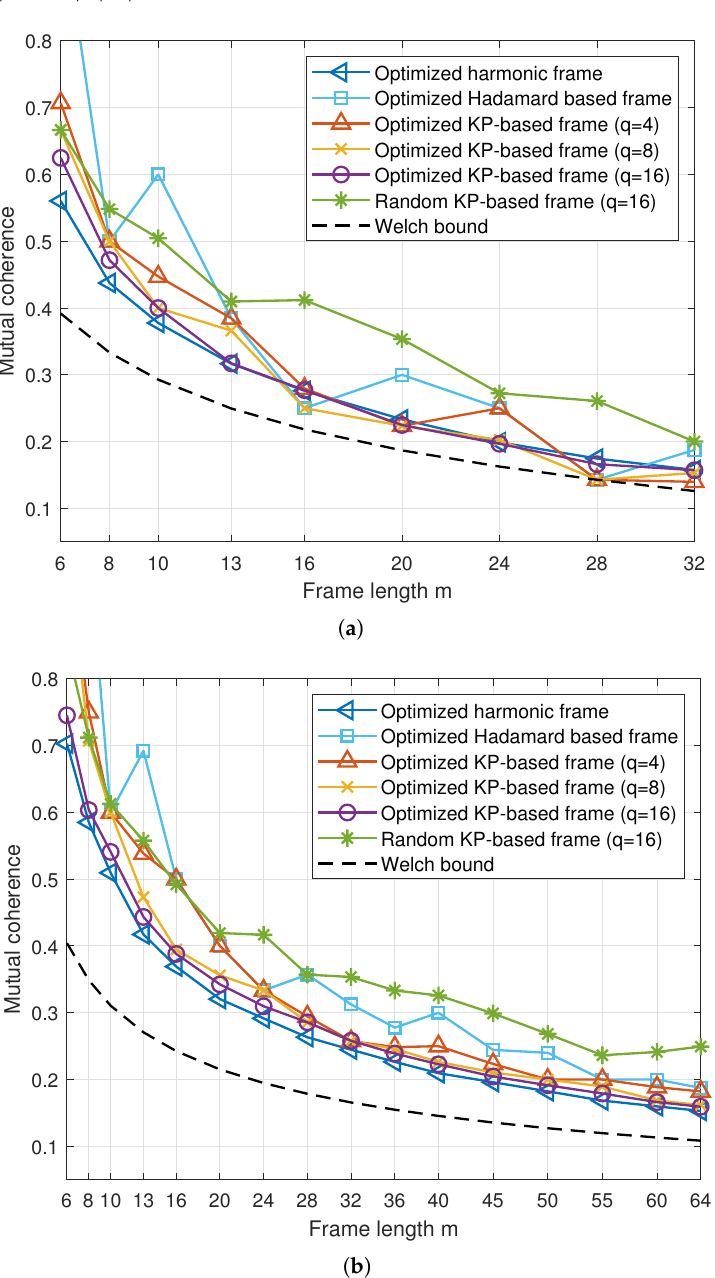
Figure 2. The mutual coherence of various frames over frame length m . ( a ) N = 64, ( b ) N =